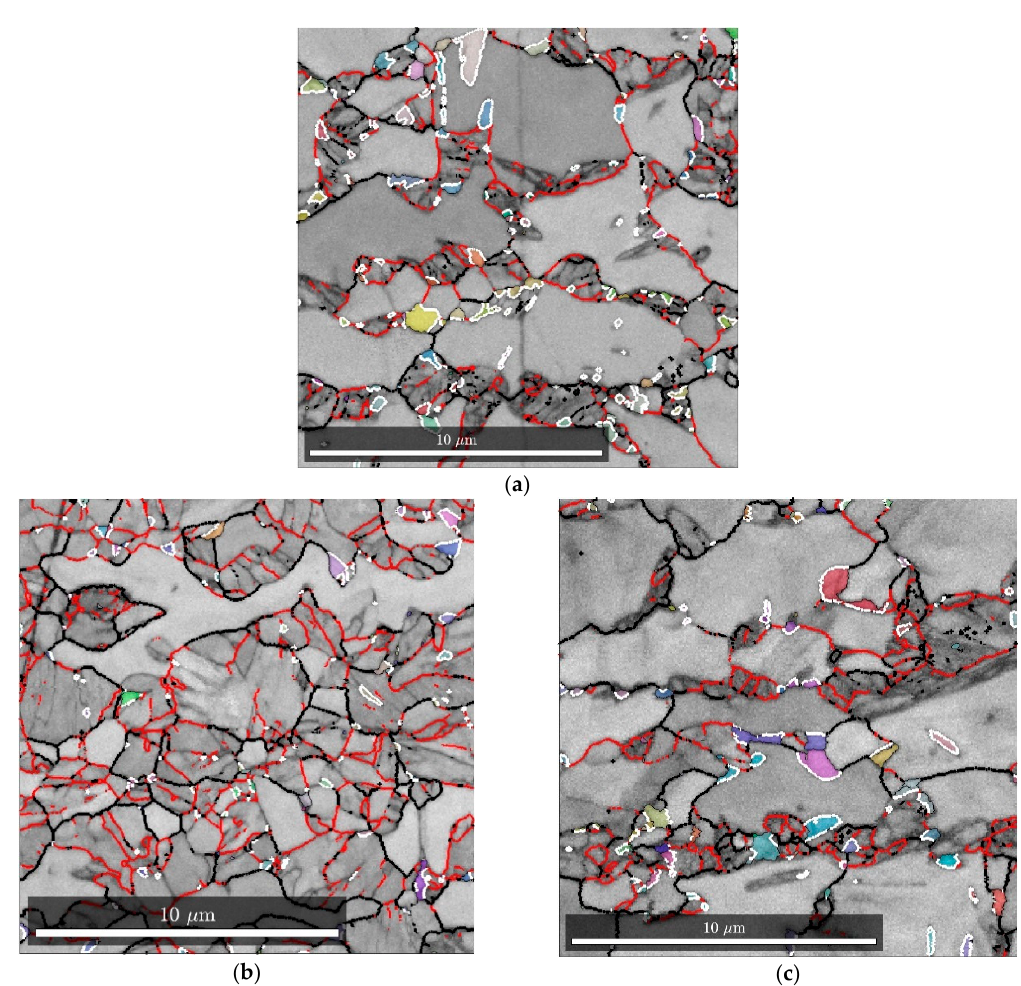
Figure 12. Electron backscatter diffraction (EBSD) band contrast image overlaid with indexed retained austenite grains (random coloring). White boundaries indicate Kurdjumov–Sachs type relationship between γ and α . Black boundaries mark prior austenite grains and red boundaries indicate packet boundaries. ( a ) Steel A quenched to 150 °C, ( b ) Steel B quenched to 275 °C and ( c ) Steel C quenched to 100 °C. All specimens partitioned at 450 °C for 100 s.